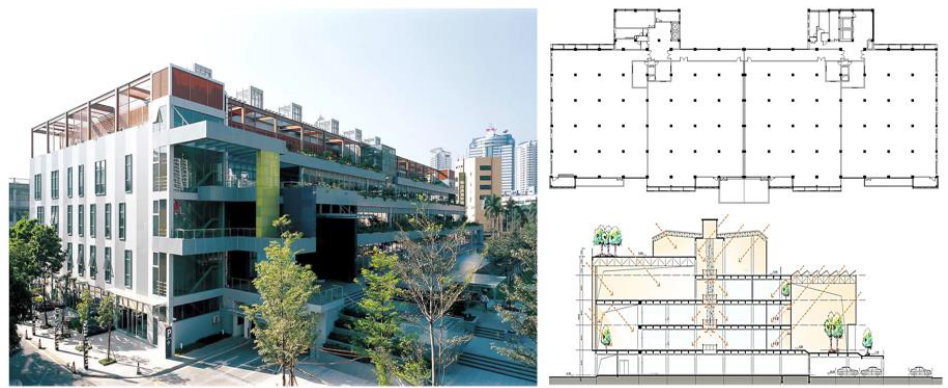
Figure 5. The green building of the case study.